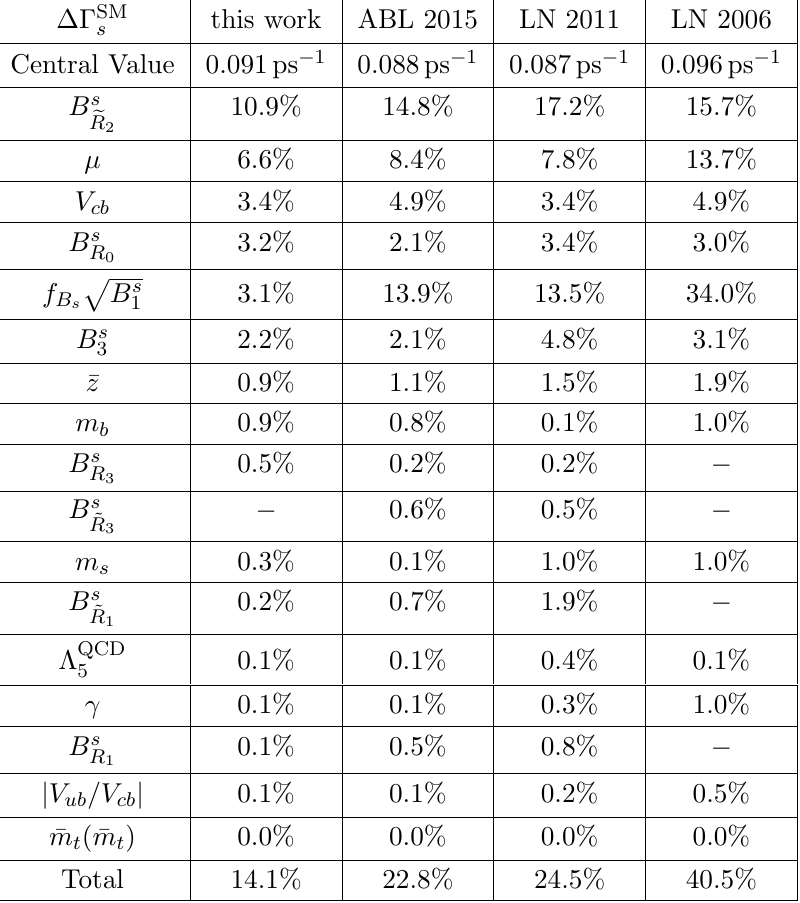
Table 8 . List of the individual contributions to the theoretical error of the decay rate di(cid:11)erence (cid:1)(cid:0) s within the Standard Model and comparison with the values obtained in 2015 [31], in 2011 [128] and in 2006 [87]. We have used equations of motion in the current analysis to get rid of the operator ~ R 3